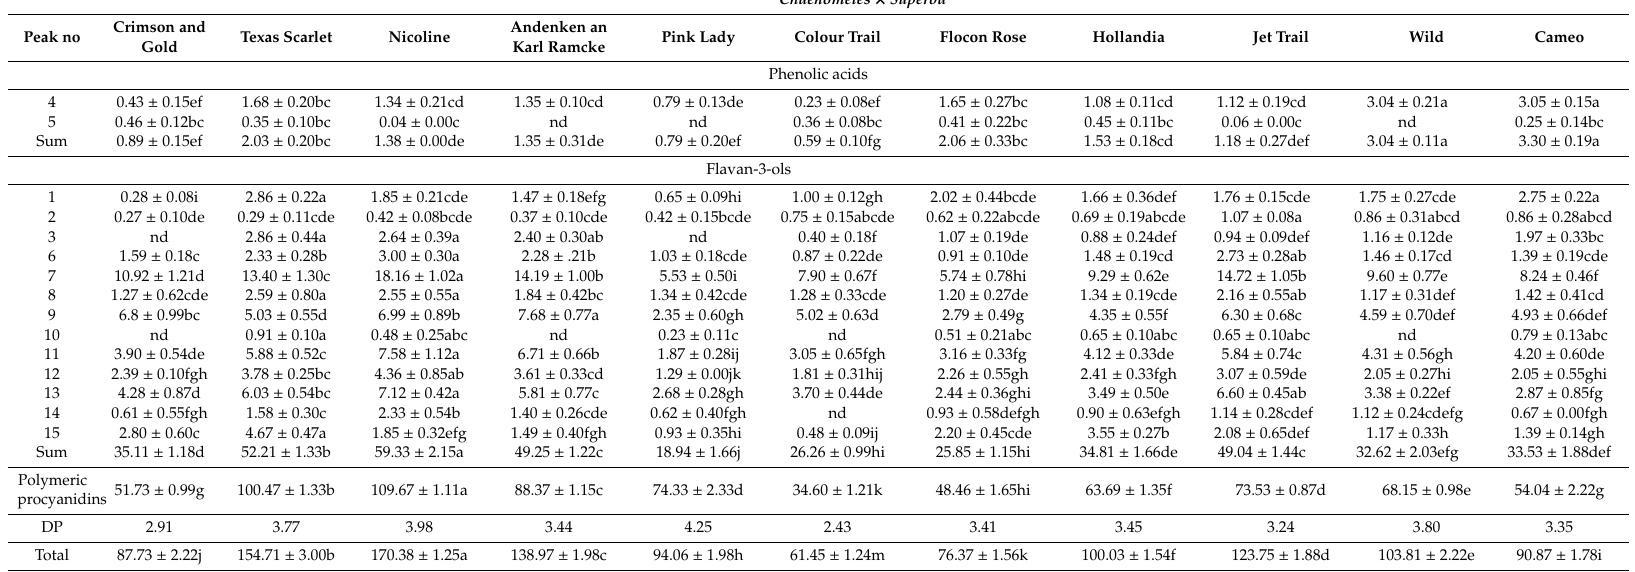
Table 3. Content of phenolic compounds (g / kg dw) invarious species and cvs. of Chaenomeles